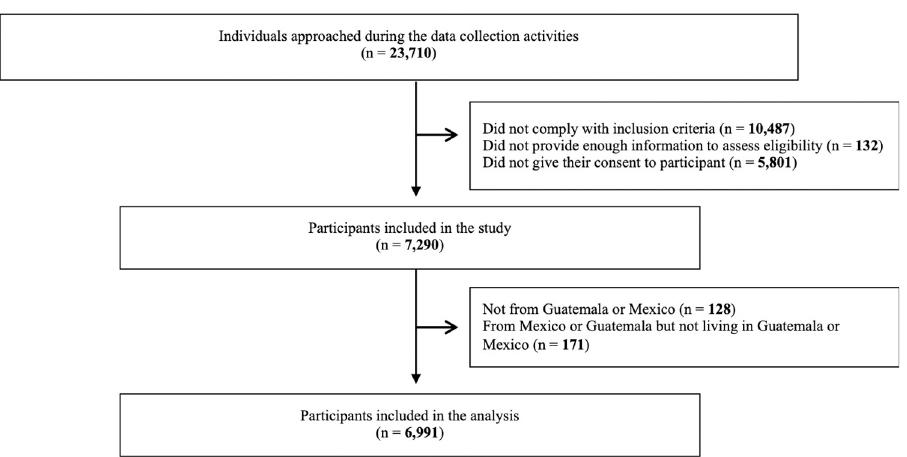
Fig 1. Flowchart of the selection of study